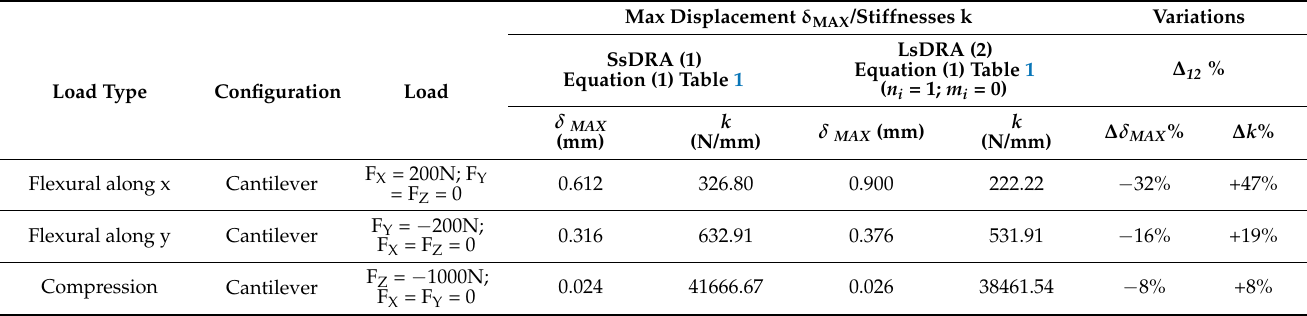
Figure A5. A comparison of the compression stiffness (upsetting) of the ( a ) SsDRA and ( b ) LsDRA: deformations under a load corresponding to Fz = − 1000 N; Fx = Fy = 0. Table A1. Summary of the FEM structural analysis of the SsDRA and LsDRA and related stiffnesses.